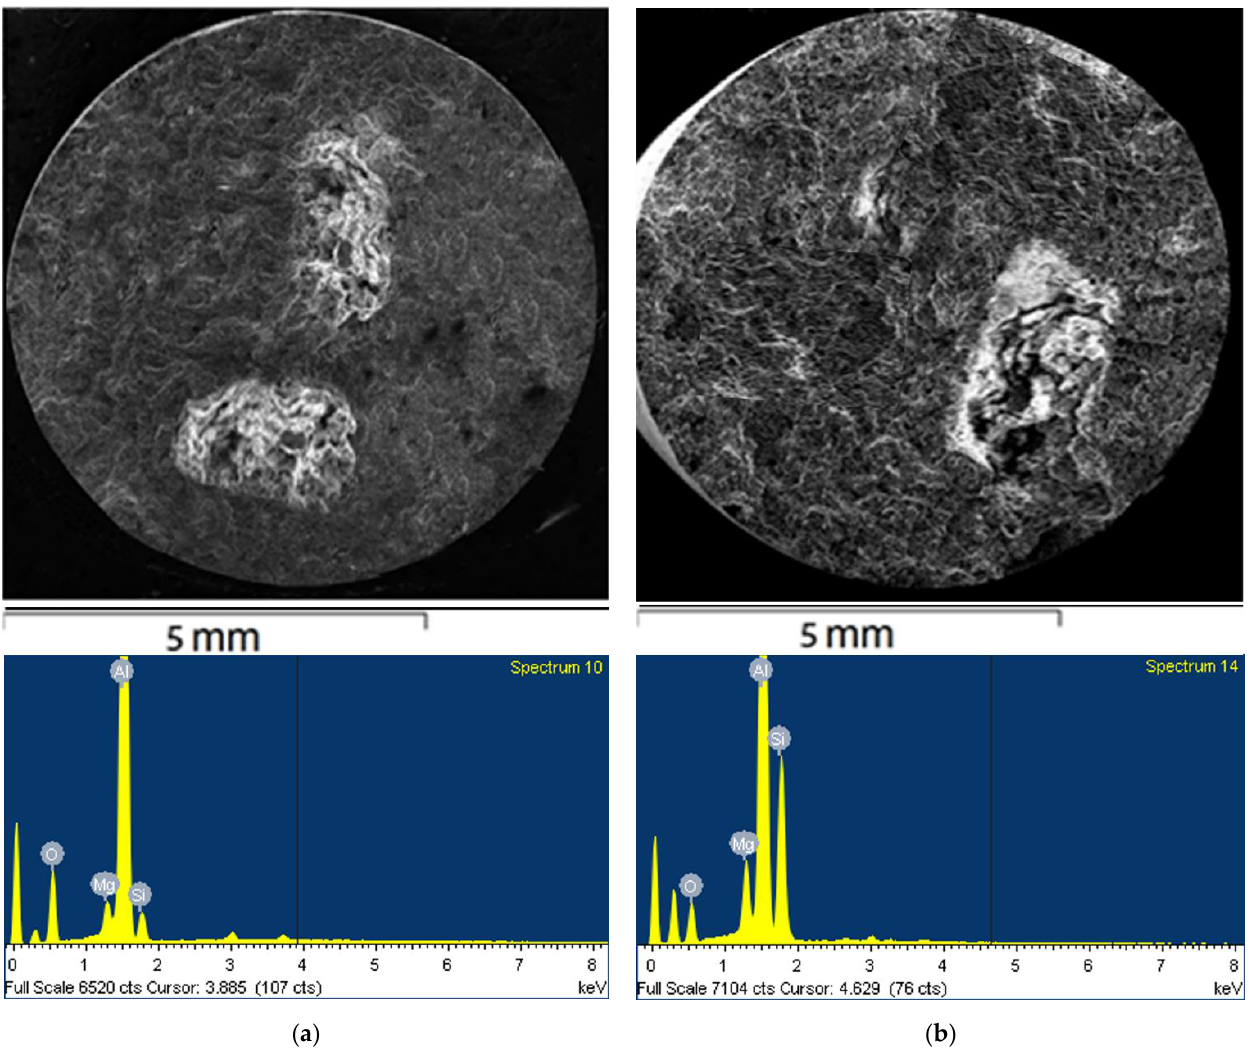
Figure 8. ( a , b ) Electron microscopy fractographs and corresponding EDX spectra (at the positions pointed with “X”) of oxide films on the fracture surfaces of two tensile-tested bars from Experiment